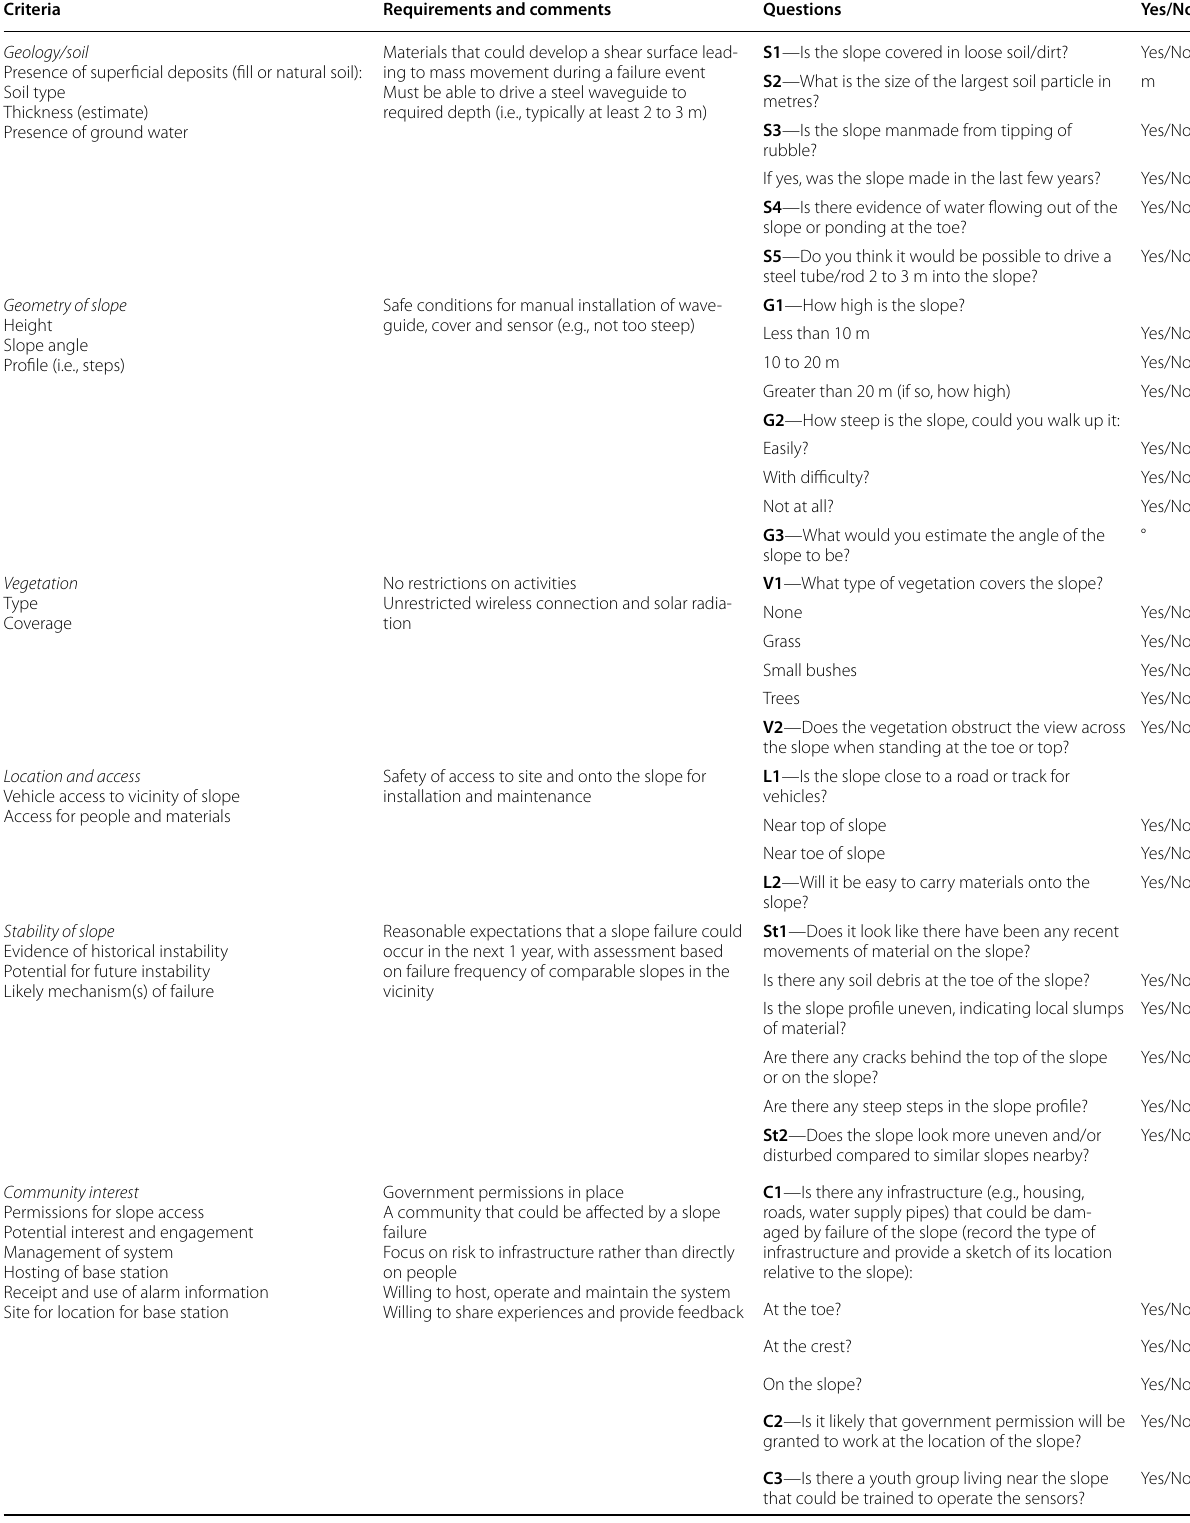
Table 1 Trial site selection check